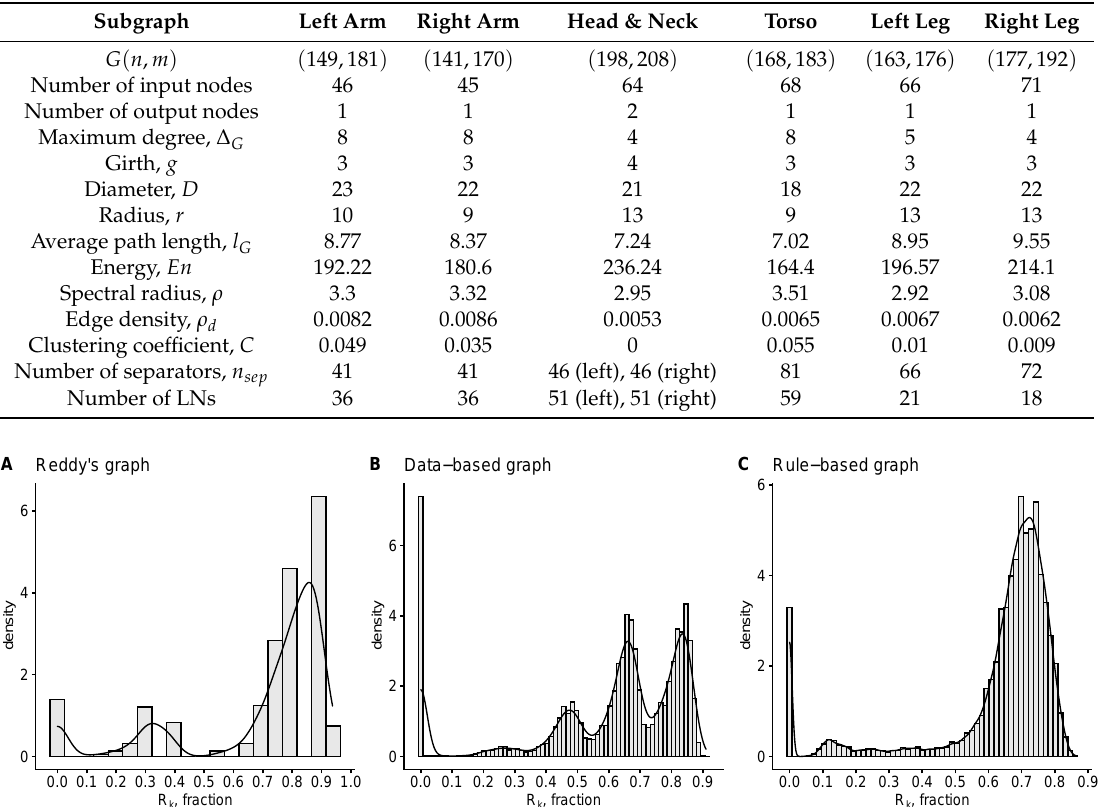
Table 2. Summary statistics for the subgraphs of the anatomy-based graph which correspond to different parts of the body.